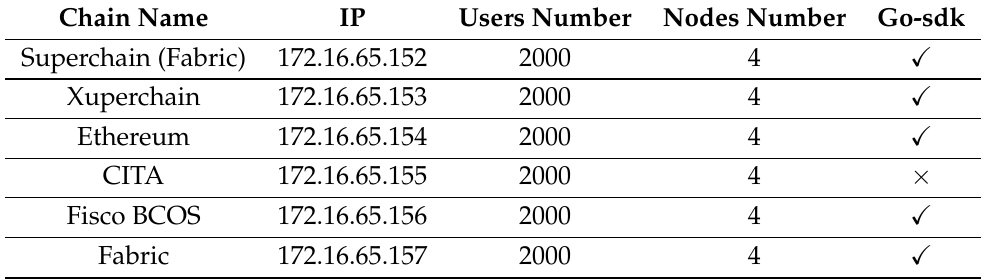
Table 2. Experiment configuration.